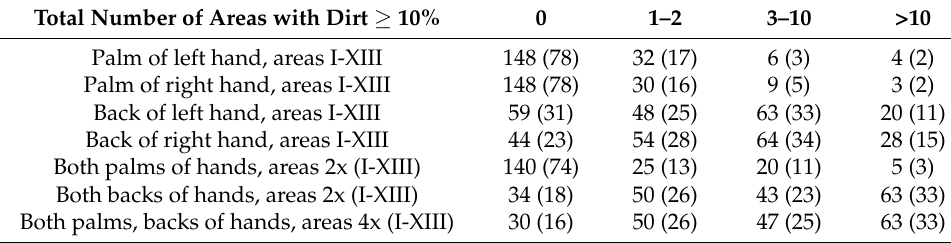
Table 3. The number of areas which were not disinfected properly by students. Total Number of Areas with Dirt ≥